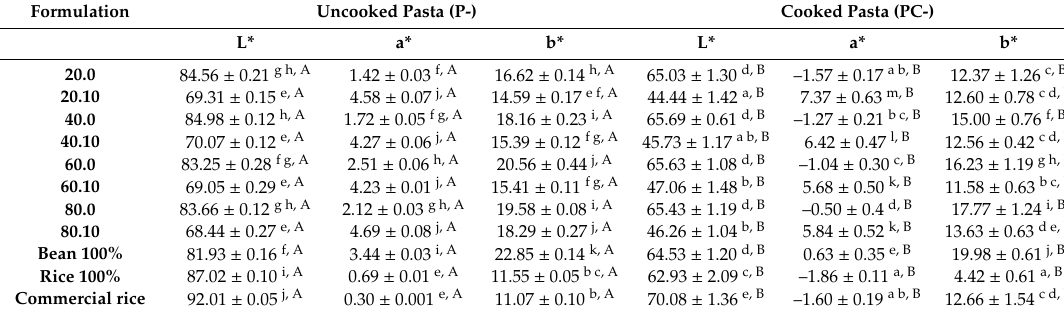
Table 6. E ff ects of the cooking process on the color values in the CIELab space of the uncooked (P-) and cooked (PC-) fettuccine and the commercial rice pasta. Formulation Uncooked Pasta (P-) Cooked Pasta